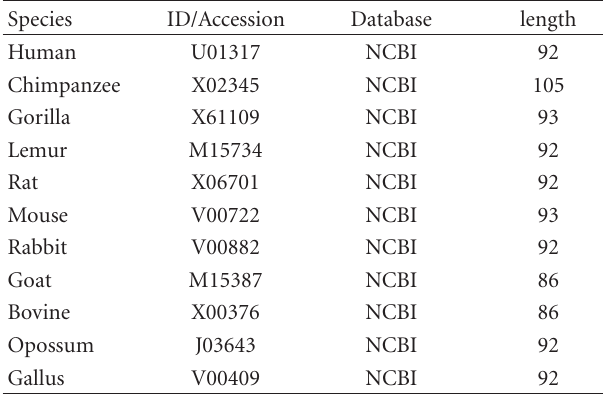
Table 1: ID Information for Exon-1 of β -globin gene of 11